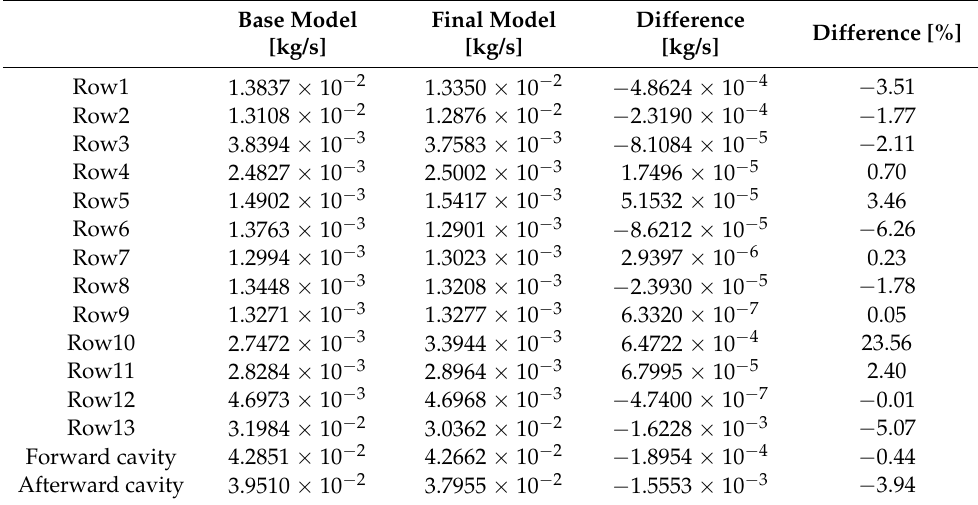
Table 7. The cooling flow rate at each cooling hole row of the base and final models.